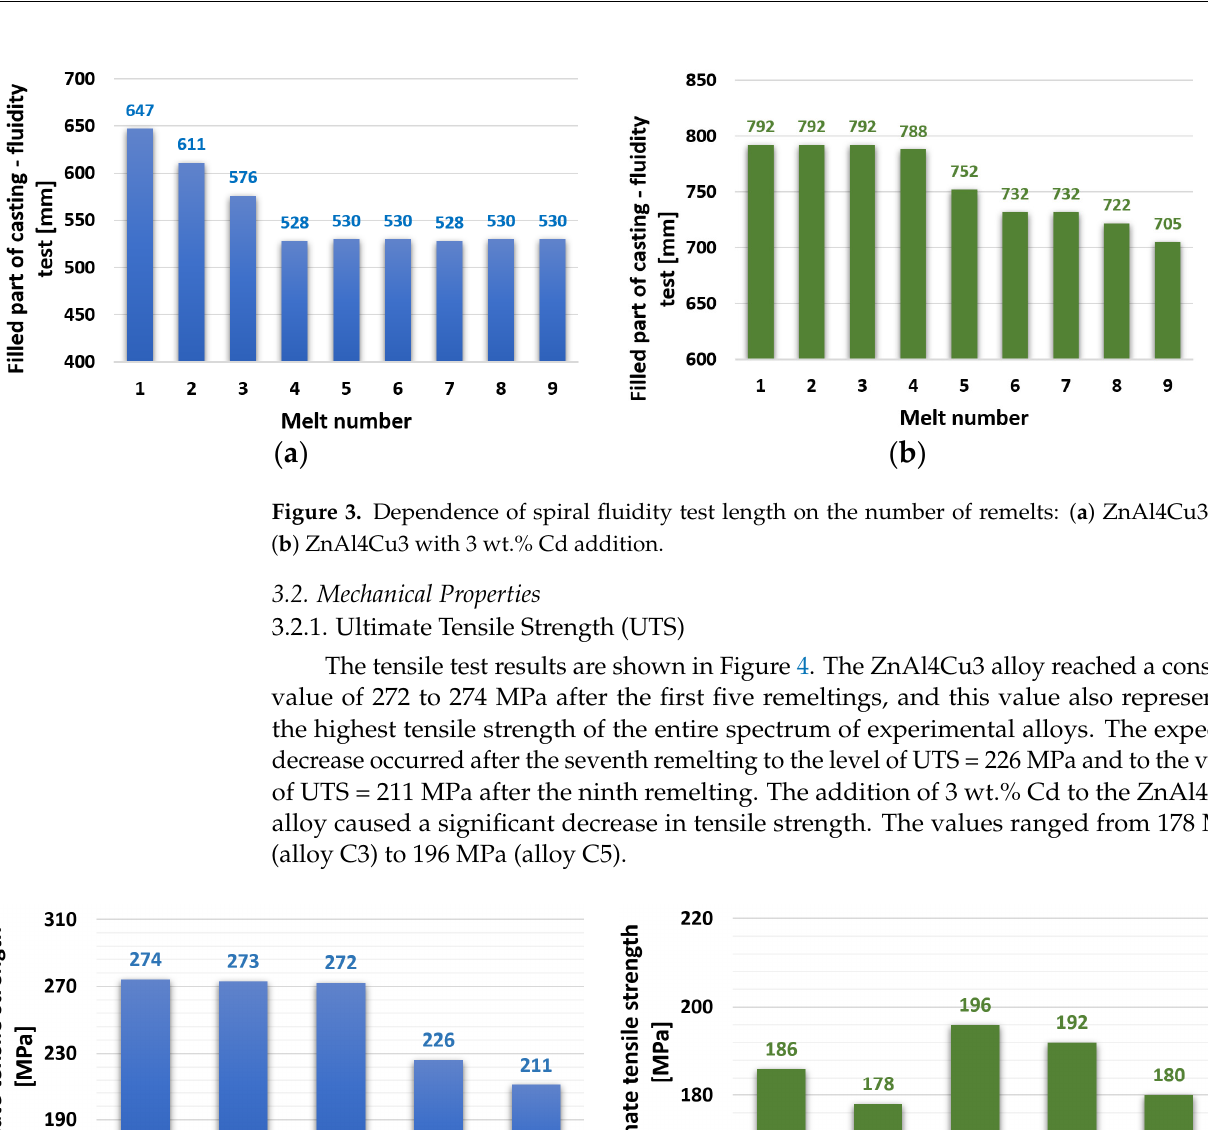
( b ) Figure 5. Dependence of ductility on the number of remelts: ( a ) ZnAl4Cu3-P1 to P9 alloys and ( b ) ZnAl4Cu3 with 3 wt.% Cd addition C1 to C9 alloys.